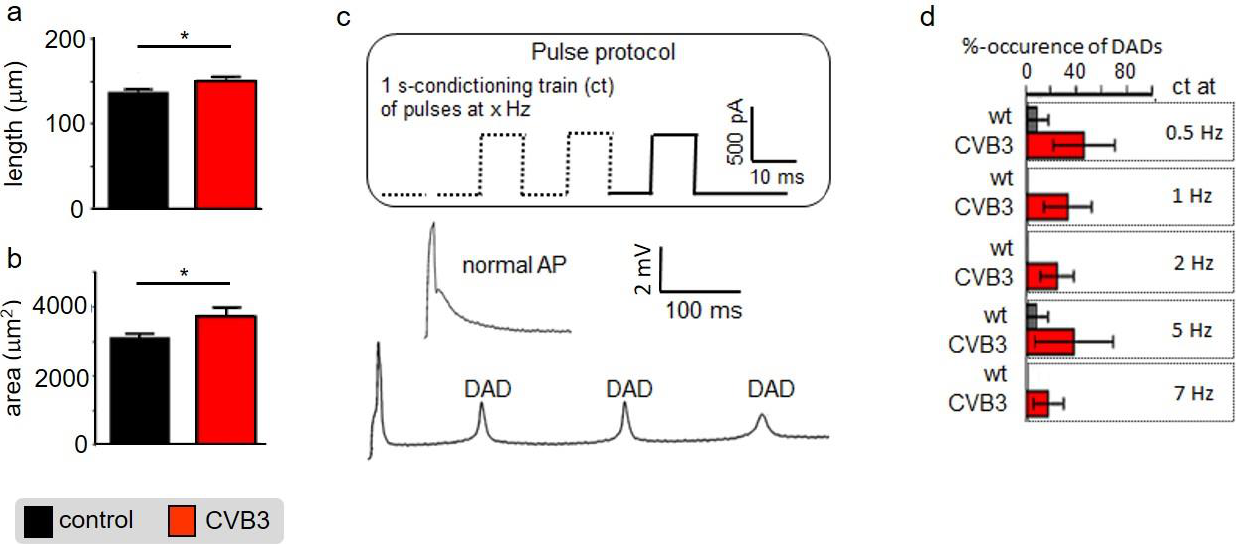
Figure 3. (a) Isolated mouse cardiomyocytes were optically measured under control conditions and under CVB3 expression. The cell length was quantified (n=11; * indicates n < 0.05;) (b) Isolated mouse cardiomyocytes were optically measured under control conditions and under CVB3 expression. The cell area was quantified (n=11; * indicates n < 0.05;) ( c ) Two exemplary induced action potentials of two different cardiomyocytes during patch clamp recordings and statistics on occurrence of delayed action potentials as relative events after stimulation at 0.5 to 7 Hz. ( a ) Example of a normal and a train of delayed depolarizations (DAD). ( d ) Cardiomyocytes isolated from transgenic CVB3ΔVP0 mice show a higher number of DAD events than the control group. The mean values ± SEM and the statistically relevant differences after a Mann – Whitney test (non-parametric) were plotted ( n = 10 – 12 each group).